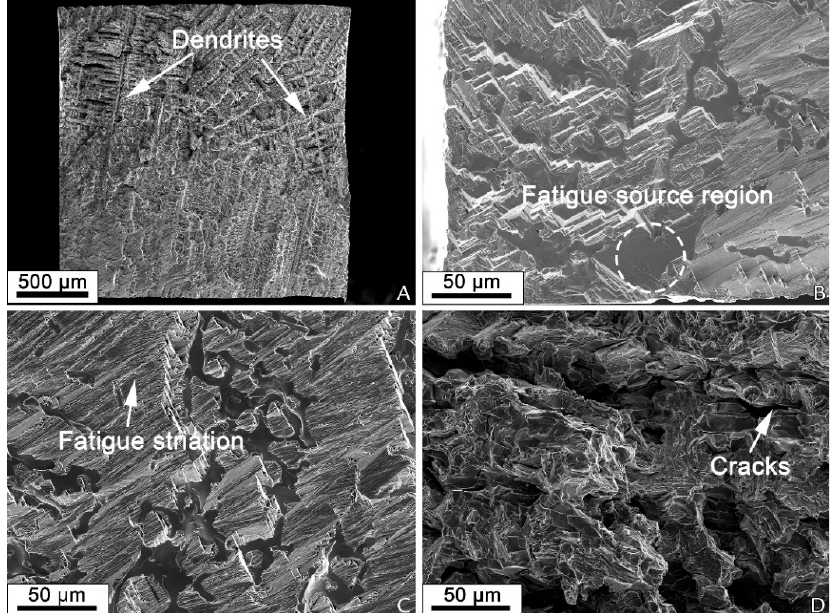
Figure 8. Fracture surfaces of cast cobalt–chromium alloy fatigue specimens showing ( A ) whole fatigue fracture surface, ( B ) fatigue crack initiation region, ( C ) crack propagation region, and ( D ) definitive transient region [172].